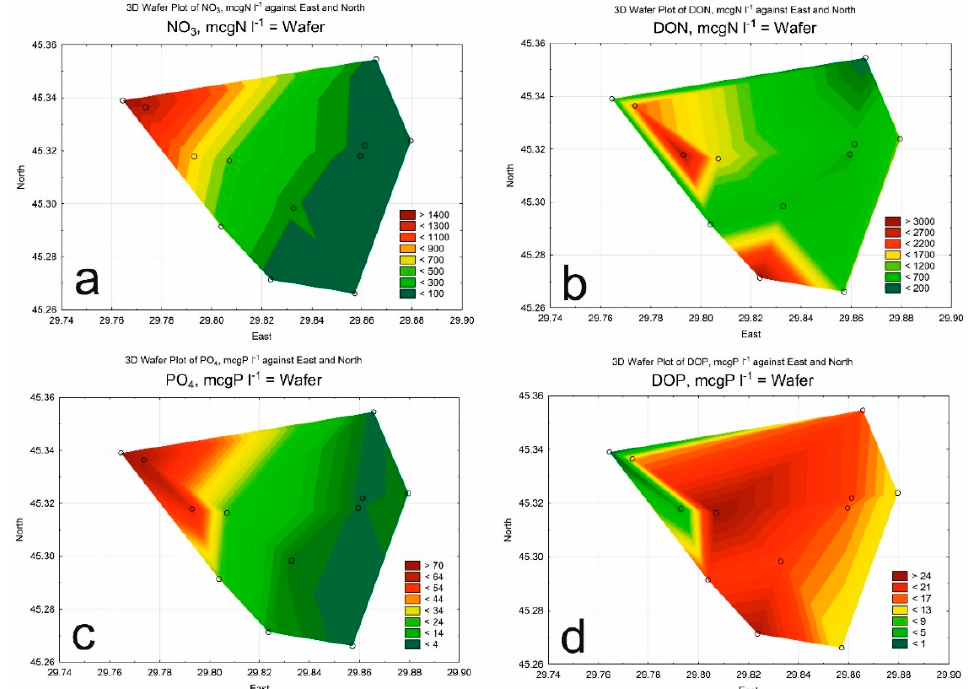
Figure 3. Statistically generated maps of nutrients from the surface horizon in the Ukrainian part of the Danube nearshore area in August 2018: nitrates (NO 3 − ) ( a ); dissolved organic nitrogene (DON) ( b ); dissolved inorganic phosphorus (DIP = PO 4 3 − ) ( c ); dissolved organic phosphorus (DOP) ( d ).